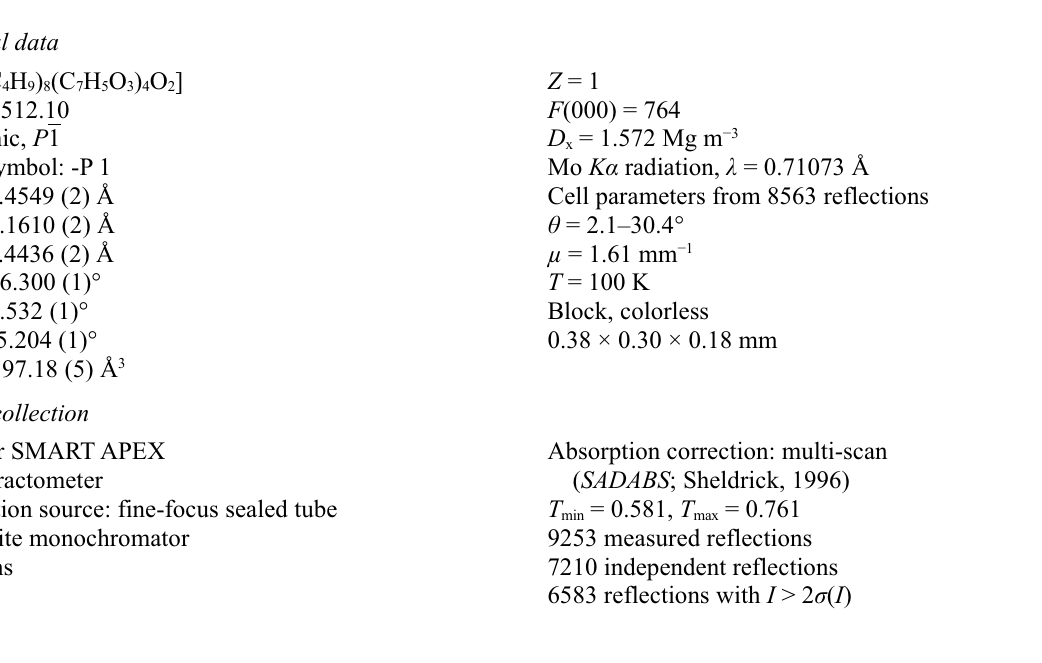
Figure 1 Thermal ellipsoid plot (Barbour, 2001) plot of [Sn drawn as spheres of arbitrary radius. The unlabelled atoms are related by a center of inversion. Octa- n -butyl-1 κ 2 C ,2 κ 2 C ,3 κ 2 C ,4 κ 2 C - tetrakis(- µ -2-hydroxybenzoato)-1:2 κ 2 O : O ;2:3 κ 2 O : O ′ ;3:4 κ 2 O : O ;1:4 κ 2 O : O ′